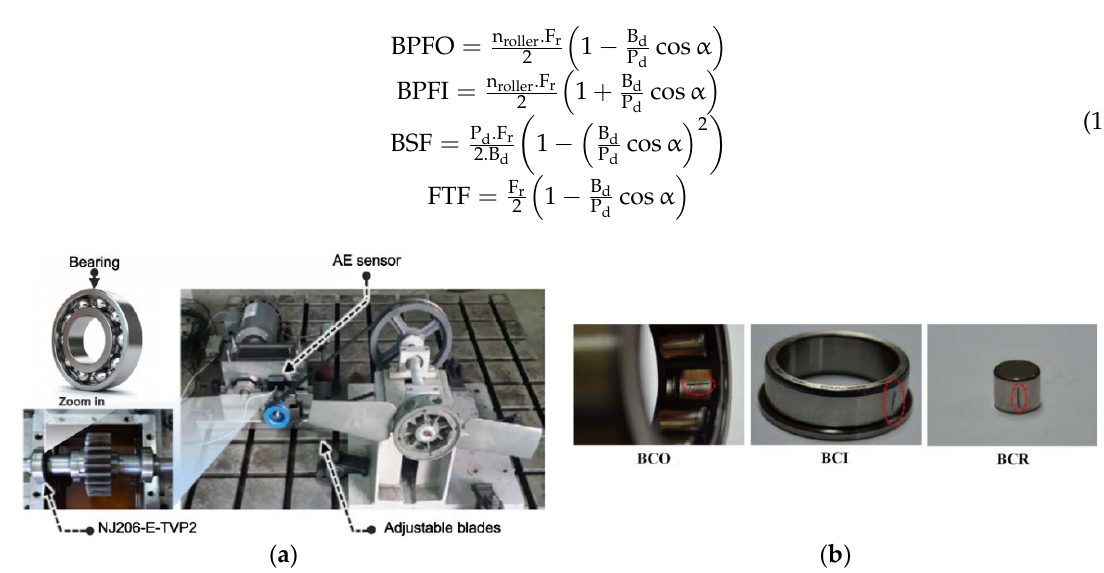
Figure 1. ( a ) AE data acquisition system; and ( b ) Primary defect conditions of bearing. Table 1. Detailed specifications for the AE sensor-based data acquisition.